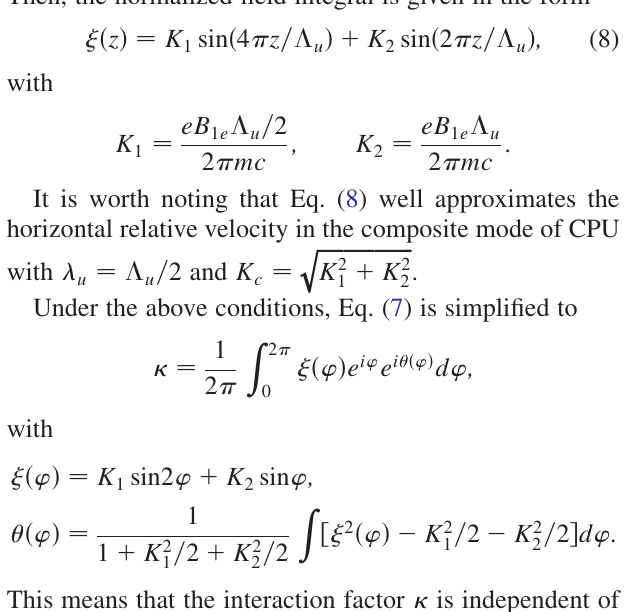
. Larger values c